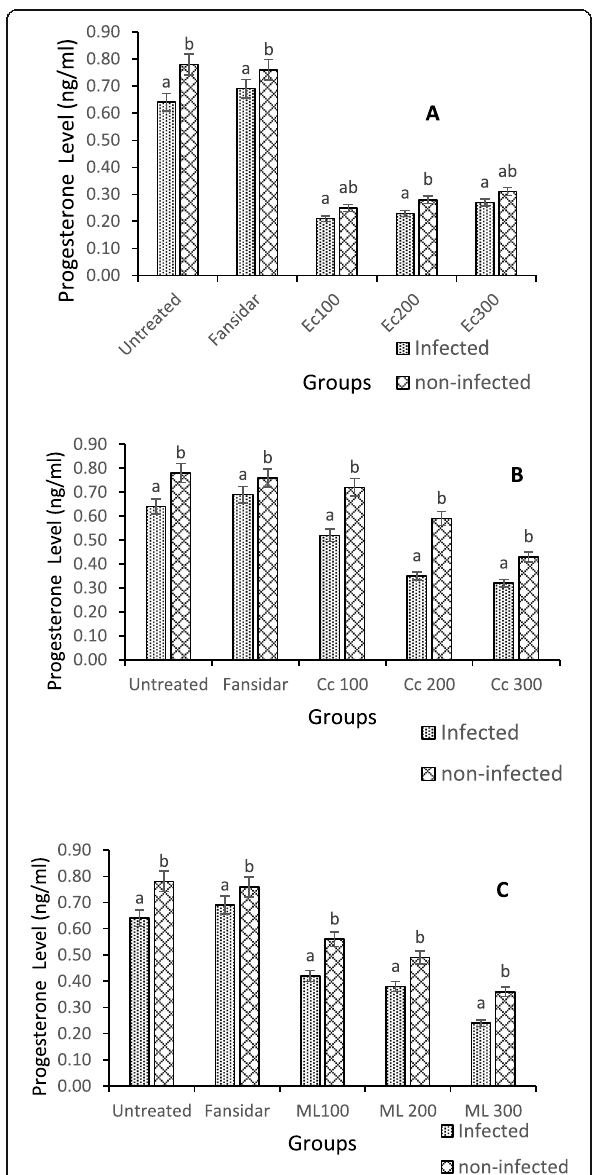
Fig. 1 Effect of different plant extracts on Progesterone level of mice treated with a E . chlorantha (Ec), b C. citratus (Cc), and M . lucida (ML)